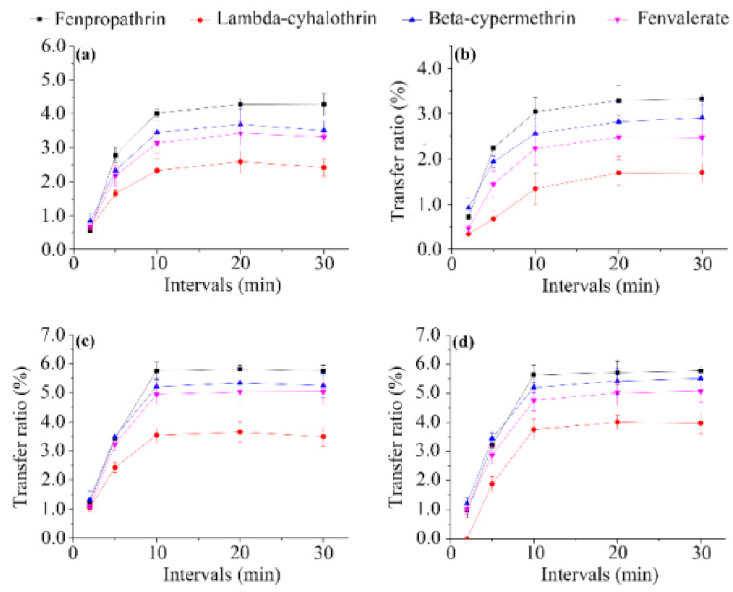
Figure 2. Effect of infusion interval on transfer ratios of the four pyrethroid residues from wolfberry ( a ); licorice ( b ); honeysuckle ( c ); and chrysanthemum ( d ) tea to infusion.